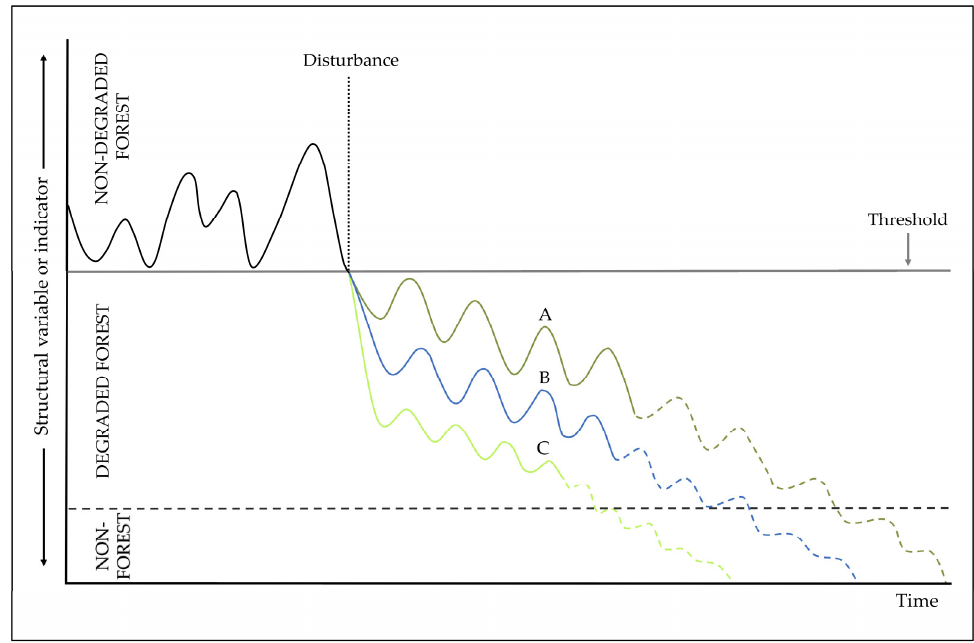
Figure 2. Example of variation in value of the indicator used to evaluate the degradation of a forest (e.g., forest cover, biomass, carbon stock). The upper left-hand side of the graph (above the threshold line) represents natural variation of an indicator in a non-degraded forest. The curves (below the threshold line) illustrate variation of an indicator in a forest subject to human-induced disturbances. Degradation occurs when the indicator value is consistently below an expected level, and the forest is considered to be degraded once it has exceeded the value attributed to the indicator(s) used in the degradation analysis. A, B and C represent different increasing levels of degradation of the forest (modified of diagrams originally formulated by [1,6,51]).